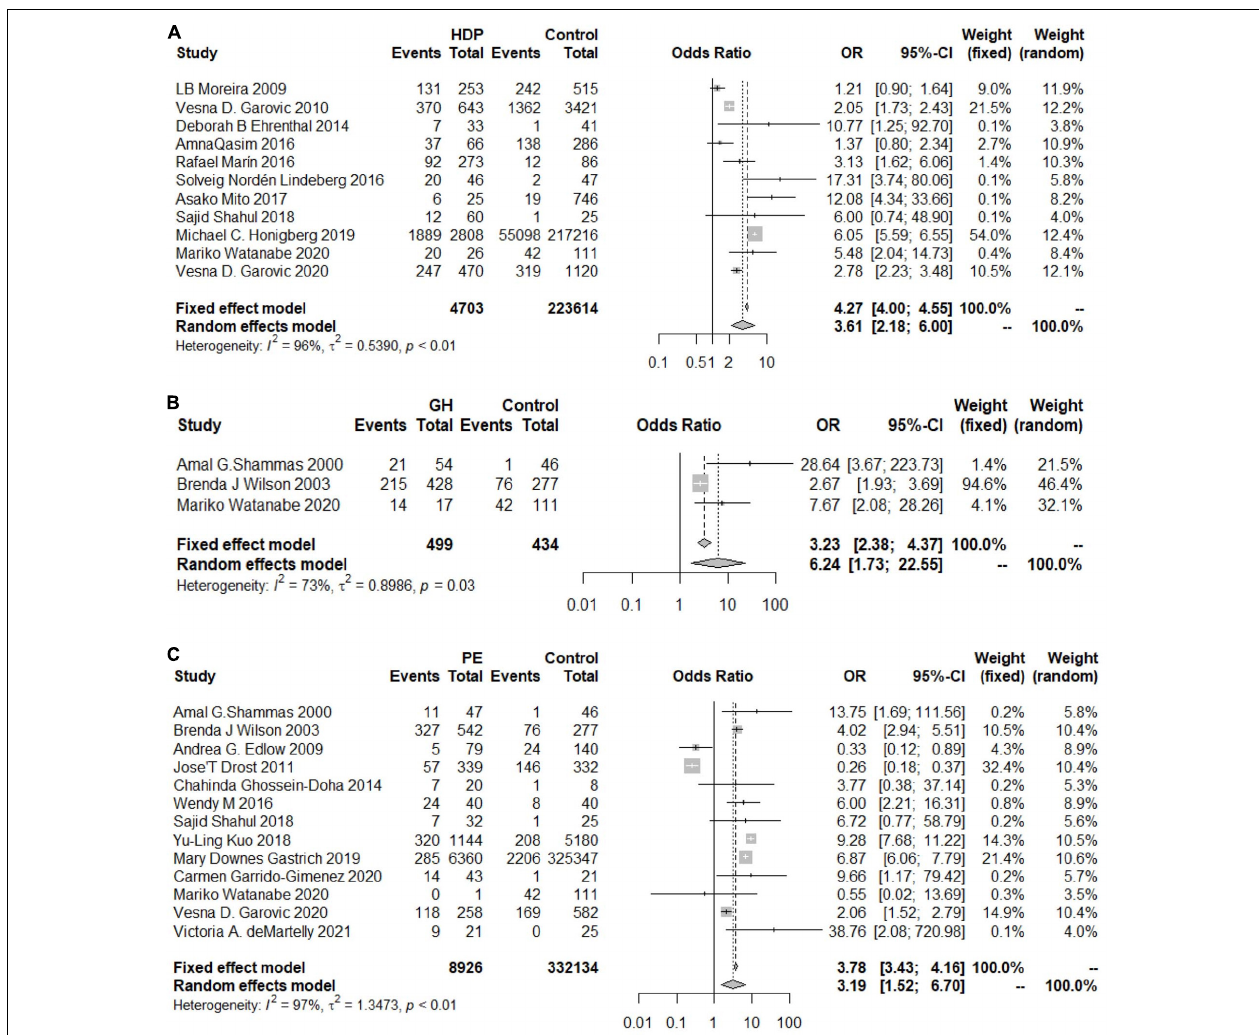
FIGURE 2 | Forest plots of the risk of developing chronic hypertension. (A) Forest plots of the risk of developing chronic hypertension in the HDP group; (B) forest plots of the risk of developing chronic hypertension in the GH group; (C) forest plots of the risk of developing chronic hypertension in the PE group.